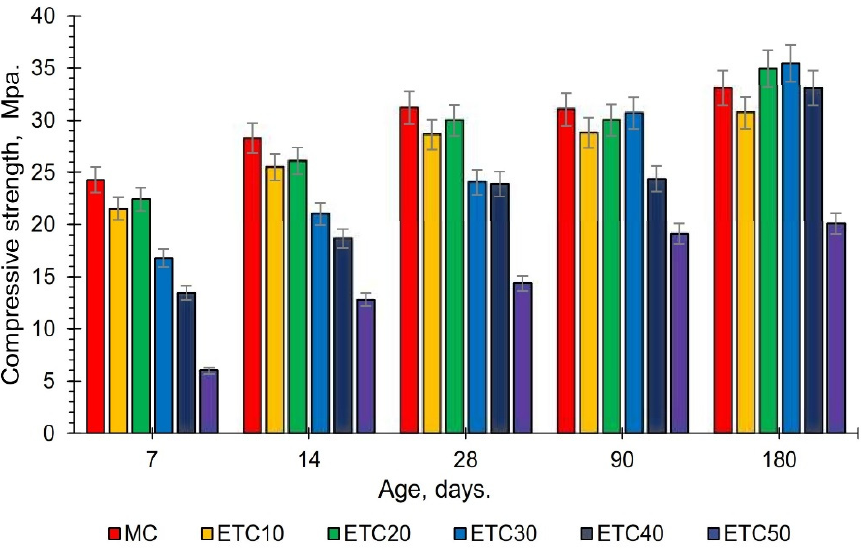
Figure 8. Compressive strength of the studied